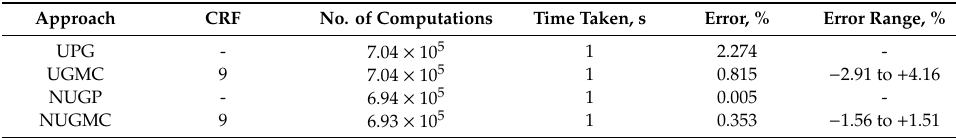
Table 7. Computation of view factor using all routines. Example with perpendicular, whole surfaces, uniform reflectance, case in Figure 4c*.